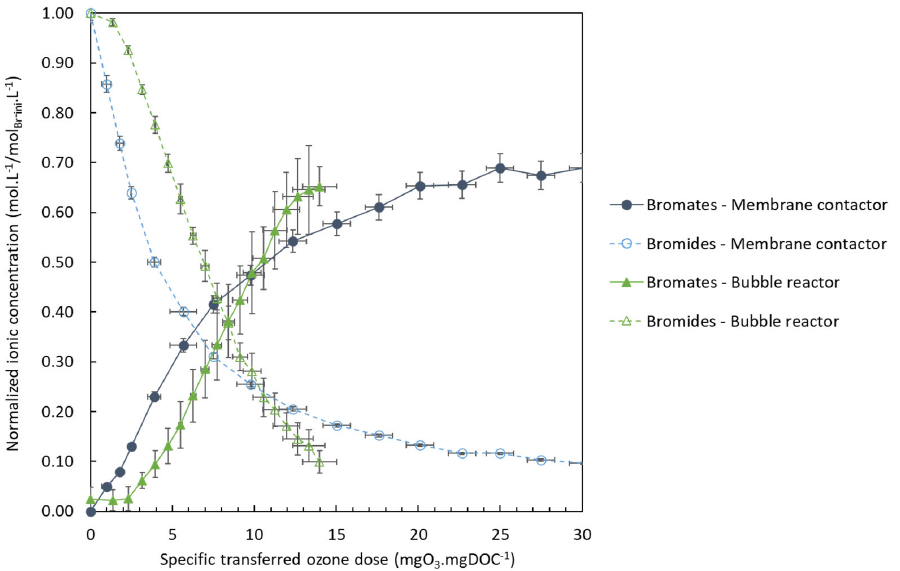
Figure 10. Normalized concentrations of bromate and bromide at pH 8.2 as a function of specific dose of ozone transferred (mgO 3 .mgDOC − 1 ).